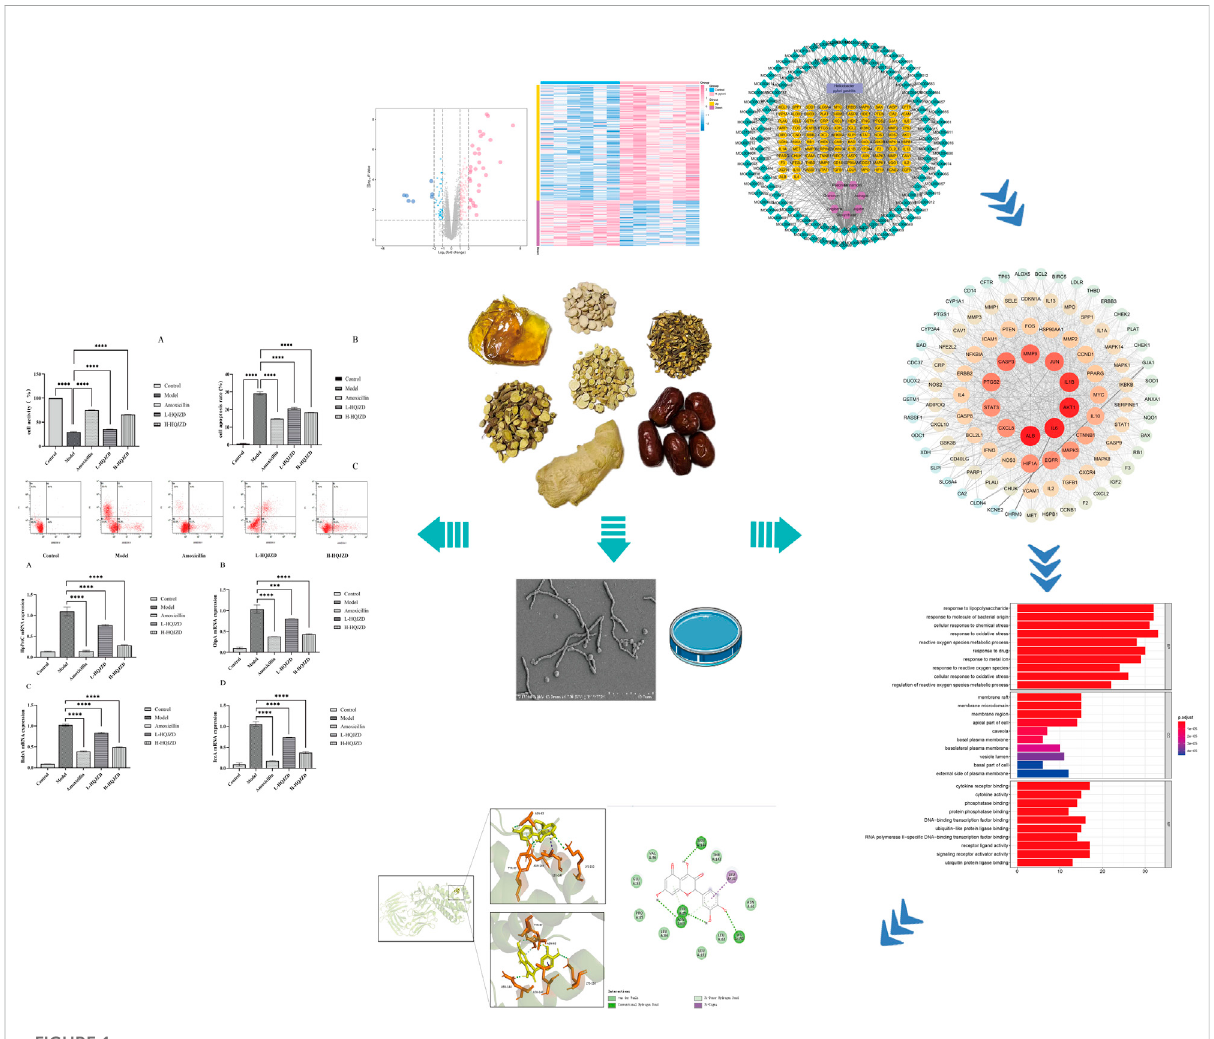
FIGURE 1 Overall design of the